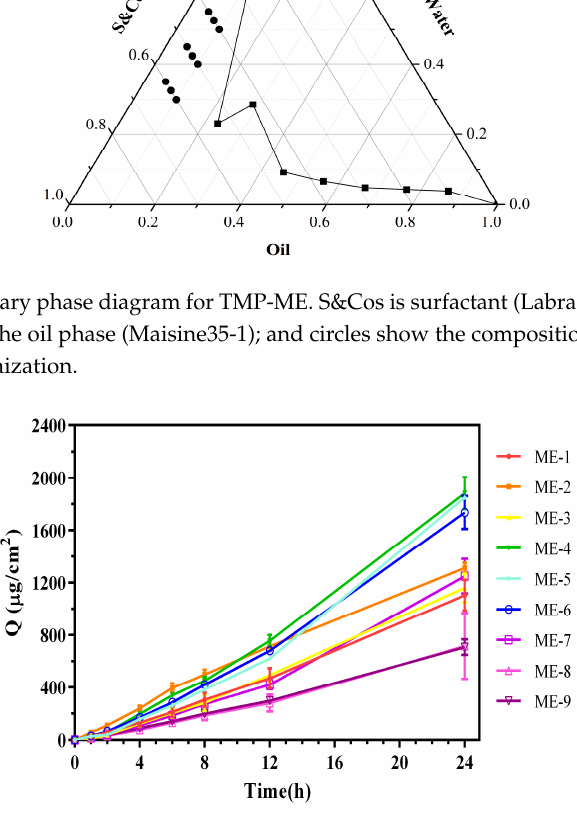
Figure 2. Cumulative in vitro skin permeation for TMP-MEs. The TMP-MEs used for formulation optimization are shown as ME-1 through ME-9.